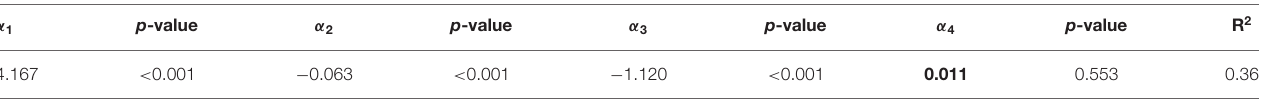
TABLE 3 | Statistical and estimated coefficients for model to evaluate the use of ZVI-sand and sand for average inactivation of E. coli from Equations (7) and (8).